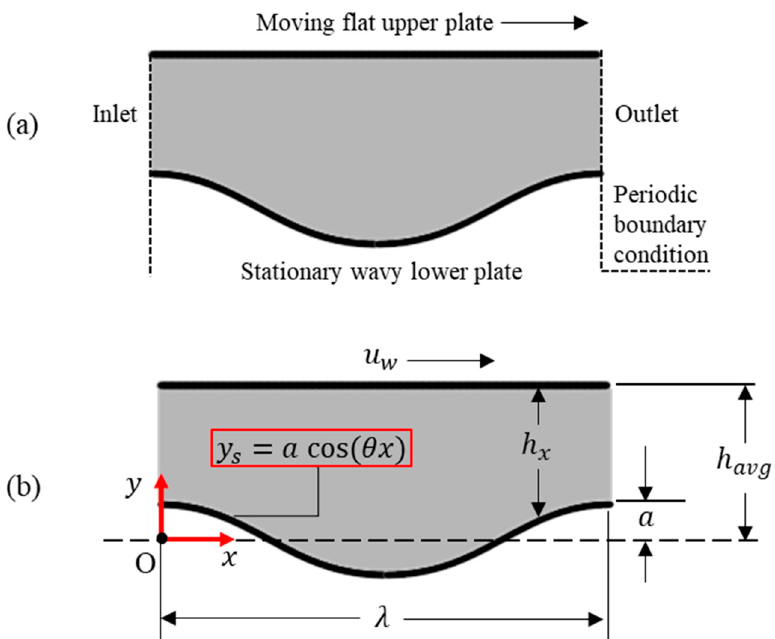
Figure 1. Computational domain and boundary conditions. ( a ) Diagram illustrating the flow domain with its boundary conditions and ( b ) geometric notation used in current study.